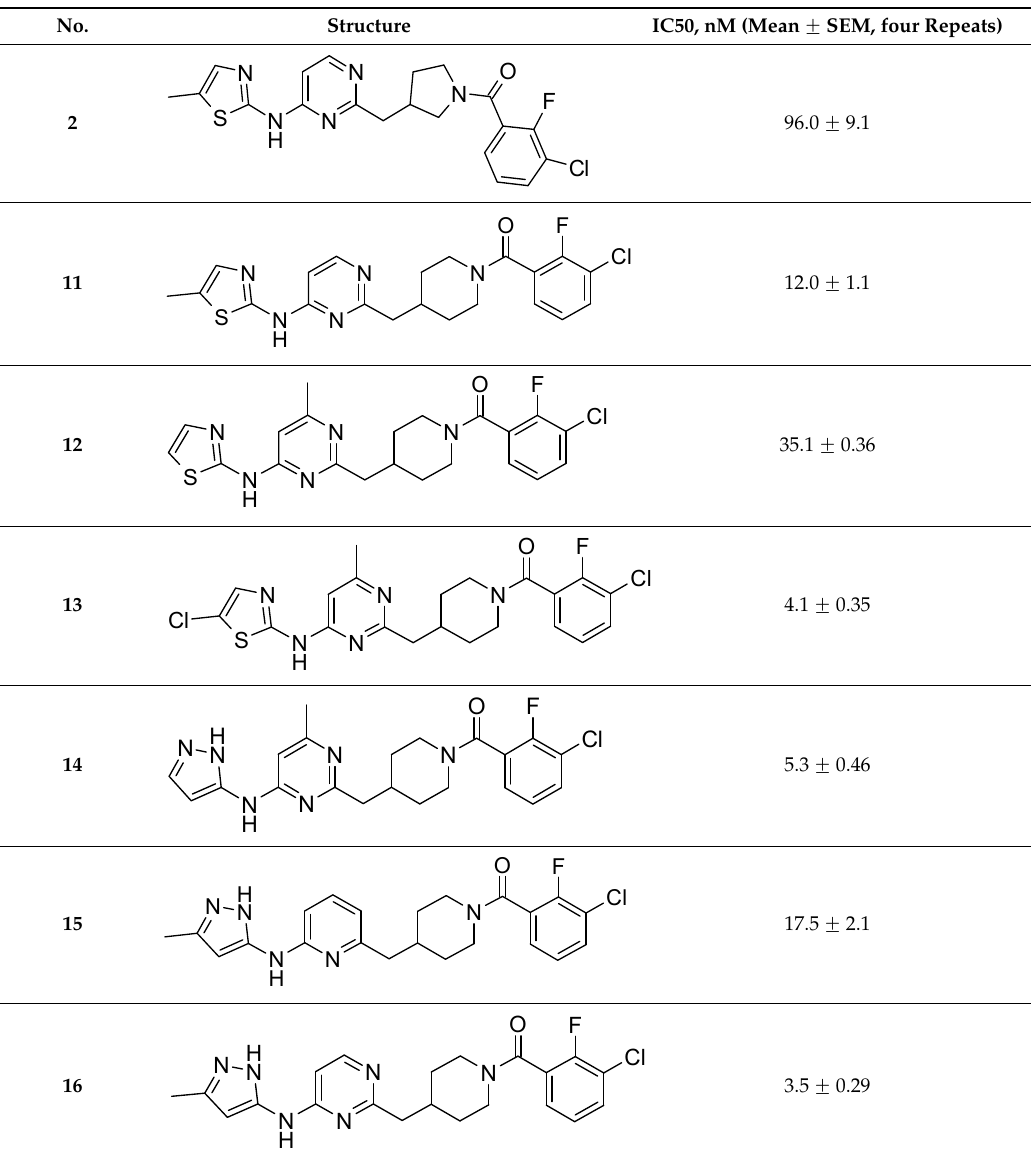
Table 2. Compounds optimized for Aurora A kinase inhibition.